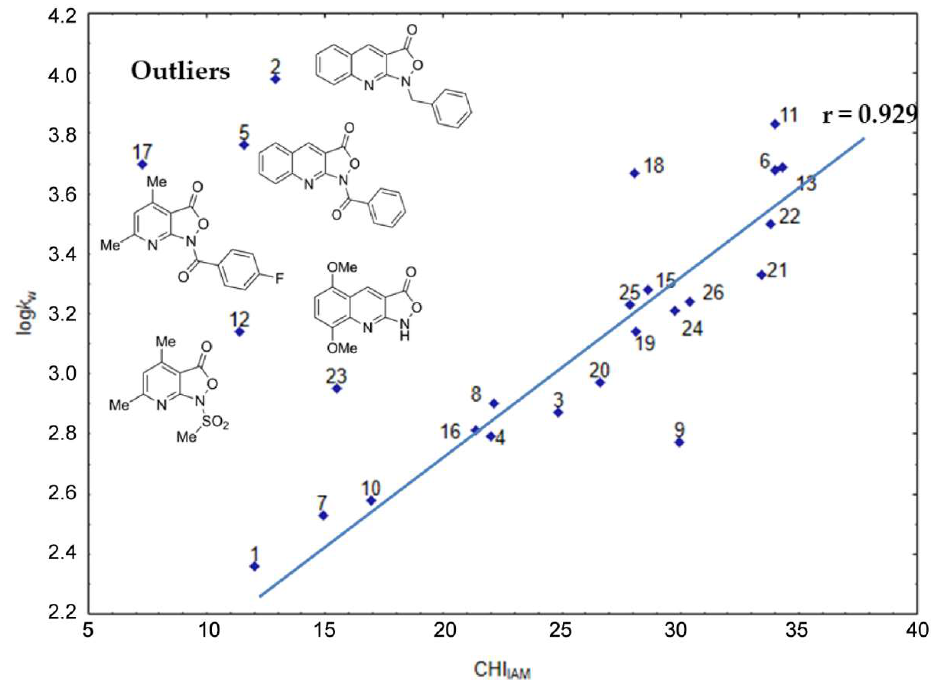
Figure 1. Plot of the CHI IAM and log k w chromatographic indices of the studied isoxazolone derivatives.